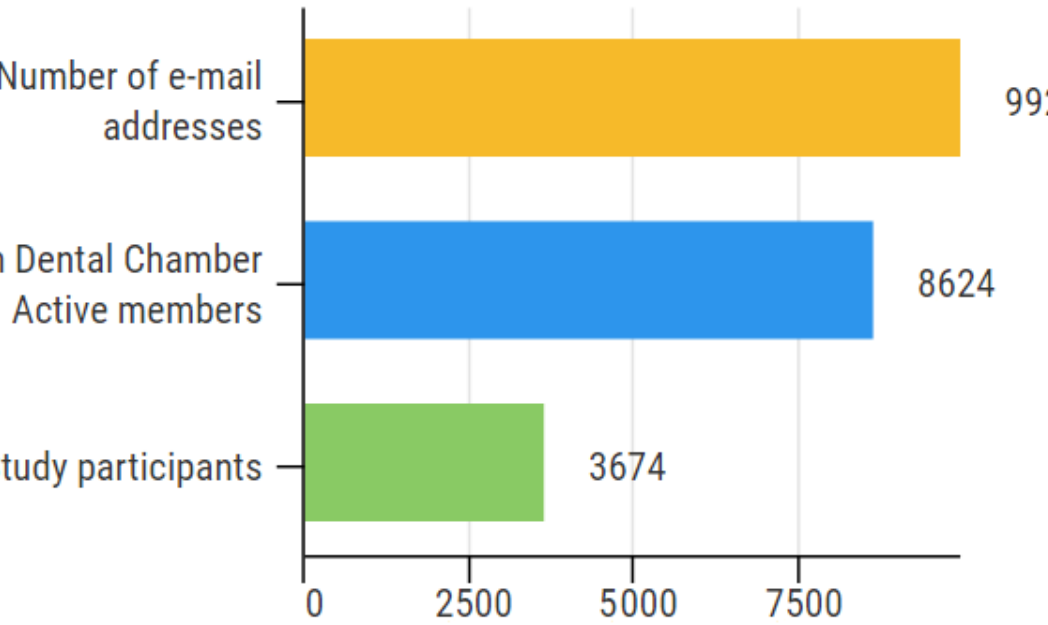
Figure 1. Response rate: 3674 participants represent 37.0% of all e-mail addresses included and 42.6% of practicing dentists in the Czech Republic.